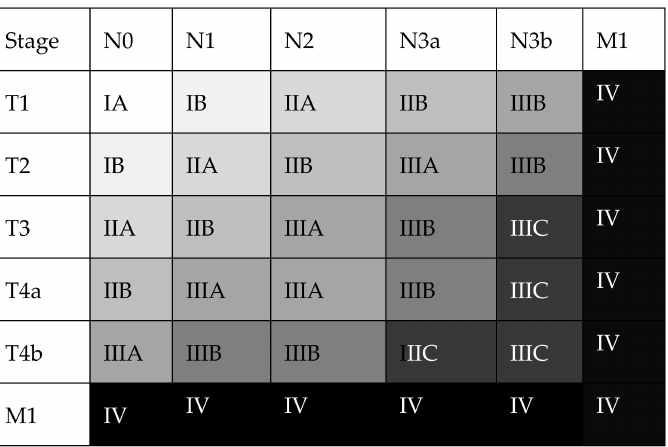
Figure 1. The 8th edition of the TNM/UICC staging system for gastric cancer. Legend: The UICC/TNM tumor stage (I–IV) is determined by the depth of wall invasion (T), lymphatic spread (N) and the presence of distant metastases (M). Adapted from